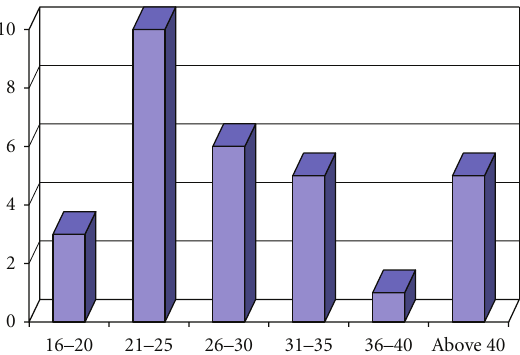
Figure 2: Age distribution in OSMF group in